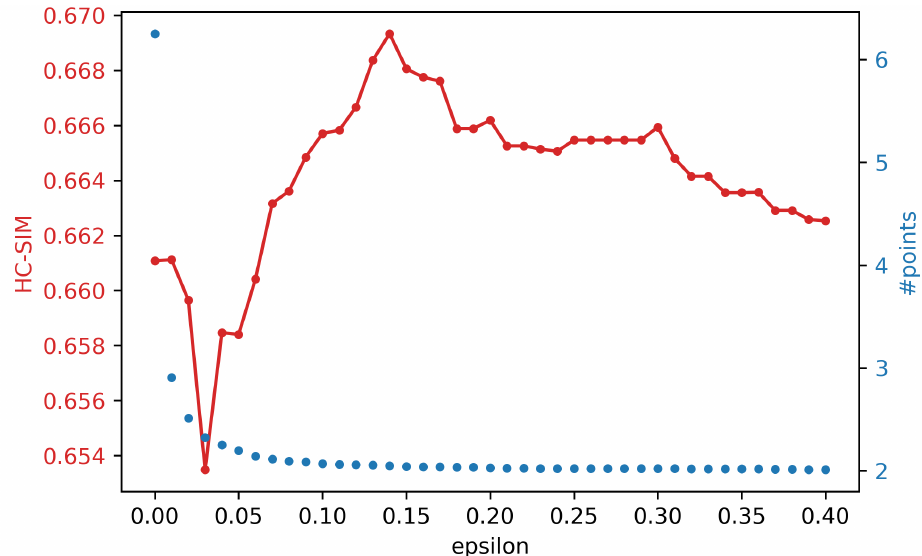
Figure 4. Average HC-SIM over the data set as function of Douglas–Peucker (DP) epsilon.